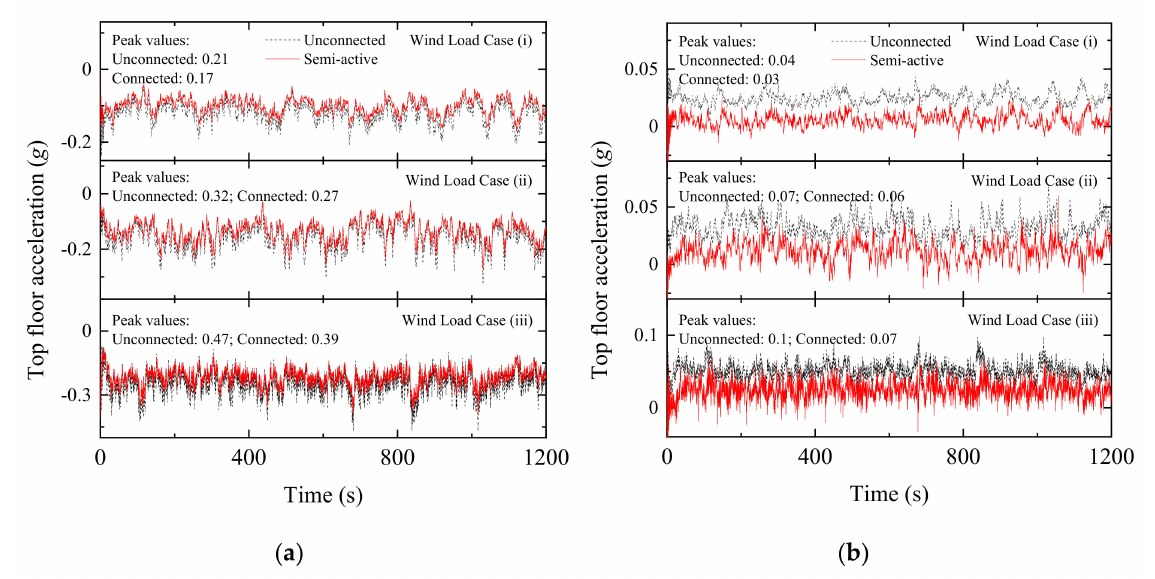
Figure 24. Time history of top floor acceleration under wind excitation in: ( a ) a building on the upwind side and ( b ) a building on the downwind side when flexible adjacent buildings are connected using semi-active MR dampers following damper Configuration 1.